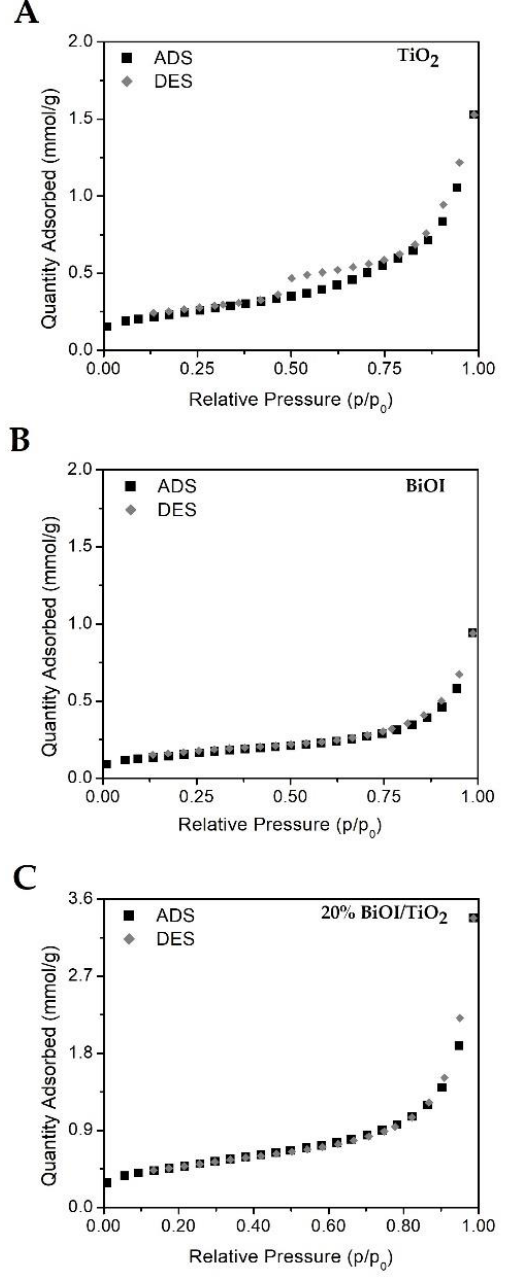
Figure 3. Nitrogen adsorption desorption isotherms for ( A ) titanium dioxide; ( B ) bismuth oxyiodide; ( C ) 20% BiOI/TiO 2 .